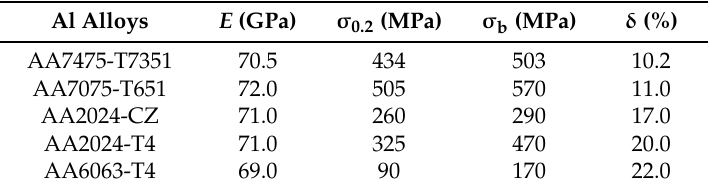
Table 1. Major mechanical properties of representative aluminum alloys.